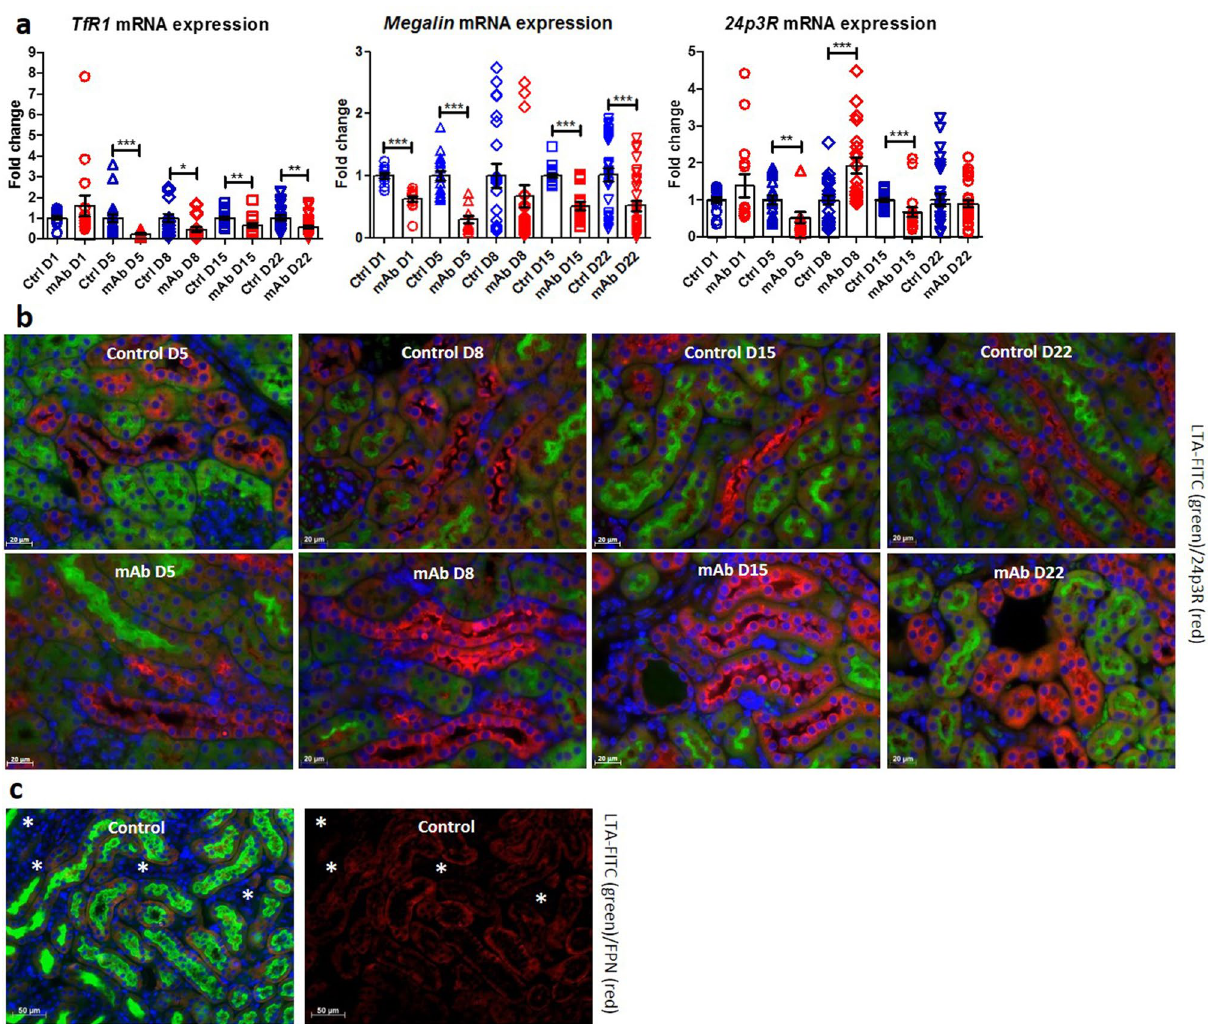
Figure 4. Kidney iron handling in mAb-injected mice. Reduced kidney mRNA expression of transferrin receptor 1 ( TfR1 ) and megalin in mAb-injected mice compared to control; 24p3R was decreased at D5 and D15, but increased at D8 ( a ). Representative images of kidney 24p3R immunostaining (red) confirming distal tubular localization as its presence is not co-localized with proximal tubule marker LTA-FITC (green), showing increased intensity in mAb-injected mice compared to control ( b ). Representative image of immunostaining on ferroportin (FPN, in red) in control kidney, present at the basolateral membrane of LTA-FITC (green) positive proximal tubules ( c ). LTA-FITC negative distal tubules are indicated by the asterisks. *p < 0.05, **p < 0.01, ***p < 0.001 compared to control using Mann–Whitney t-test; D day, Ctrl control, mAb monoclonal antibody. Scalebar = 20 µm for ( b ) and 50 µm for ( c